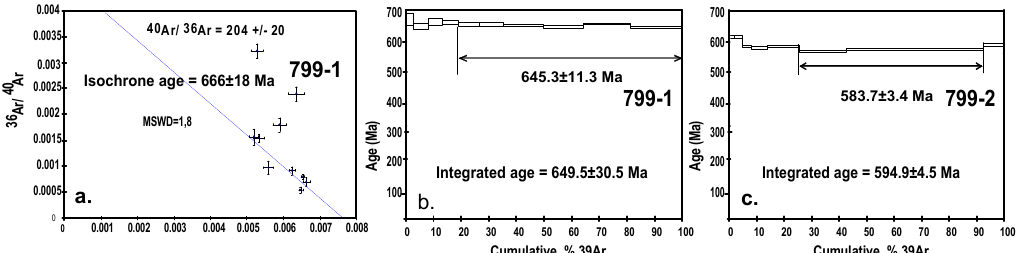
Figure 7. Results for the 40 Ar/ 39 Ar dating of YuP ( a,b ) and carbonatite phlogopite - bearing dyke ( c ) located nearby.